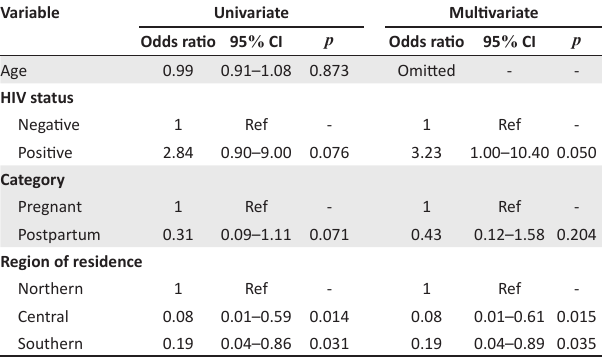
postpartum women attending antenatal and postnatal care clinics in Eswatini between April and November